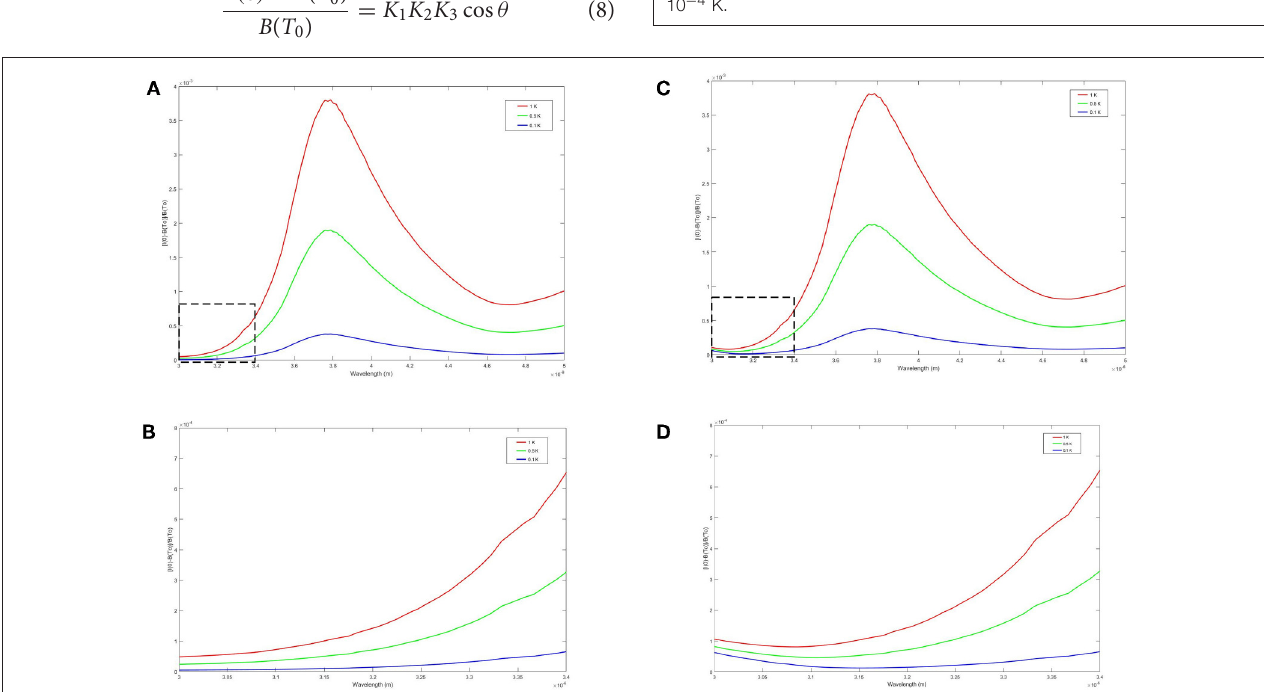
FIGURE 4 | Behavior of the theoretical approximation (A,B) , and the numerical results (C,D) , as a function of the temperature difference 1 T thermal layer for a linear temperature profile. (B,D) are magnified views of the dashed rectangles in (A,C) respectively. In both the plots of the theoretical and numerical results, it is evident that the signal decreases as the temperature difference across the thermal layer decreases.